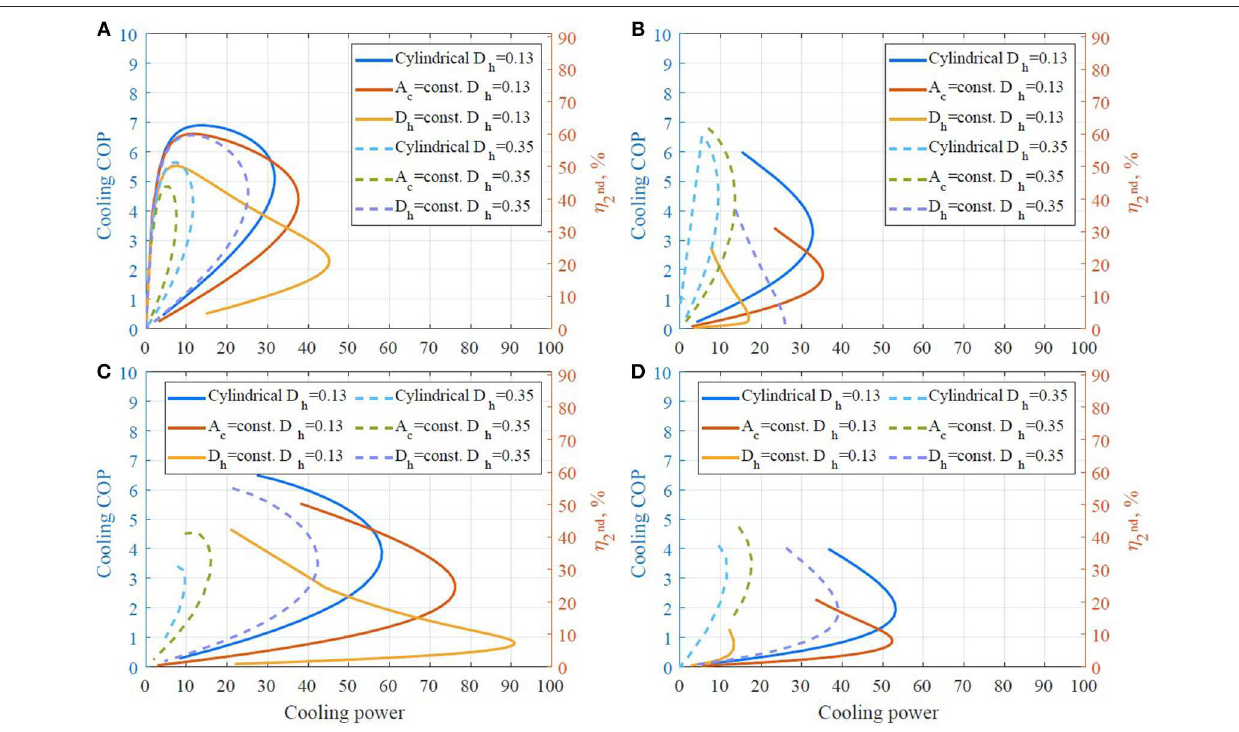
Frontiers in Energy Research |